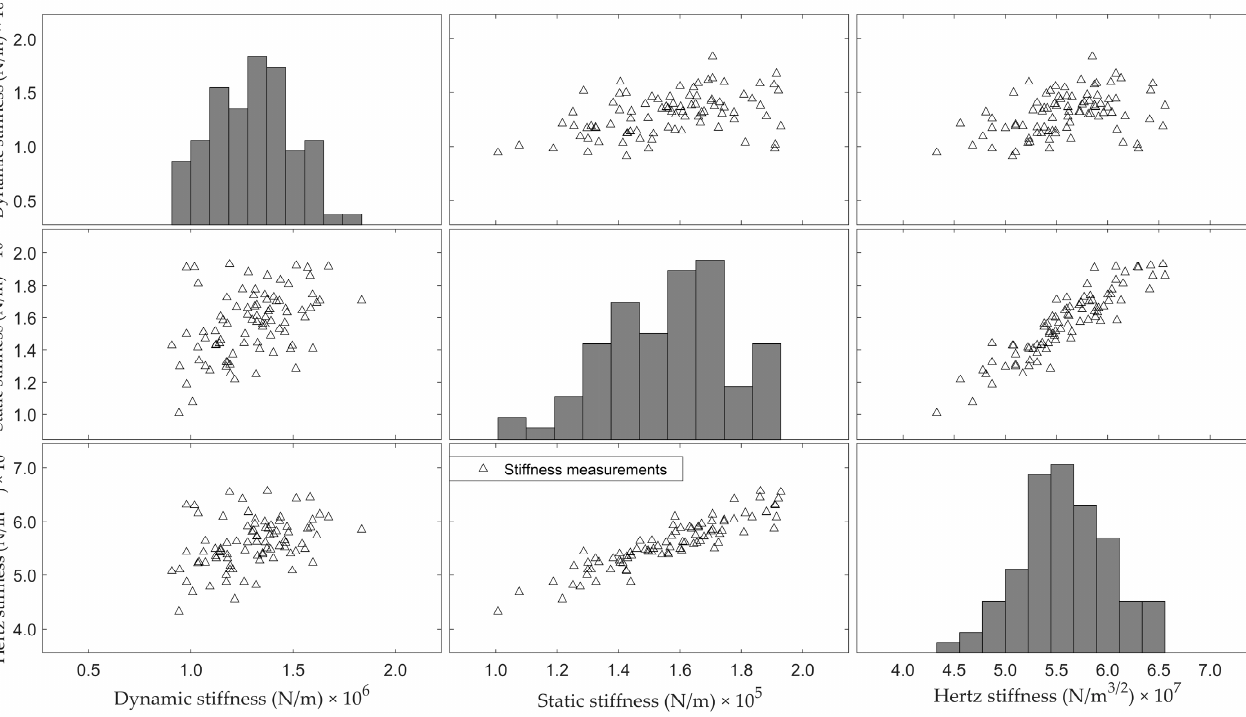
Figure 8. Relation between the static stiffness measured during quasi-static compression and Hertz stiffness ( left ), and a linear stiffness derived from impact measurements.